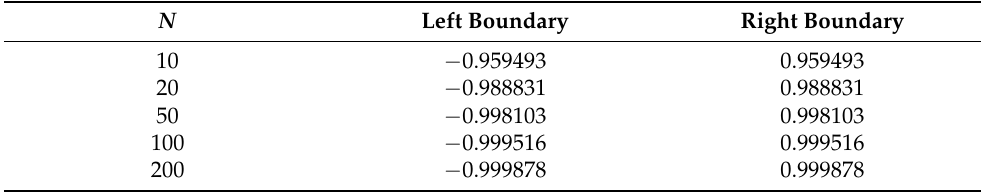
Figure A1. The zeros of P N ( E ) in units of λ 2 for N = 100. Table A1. The left and right boundaries of the energy band in units of λ 2 for different values of N . The exact values are ± λ 2